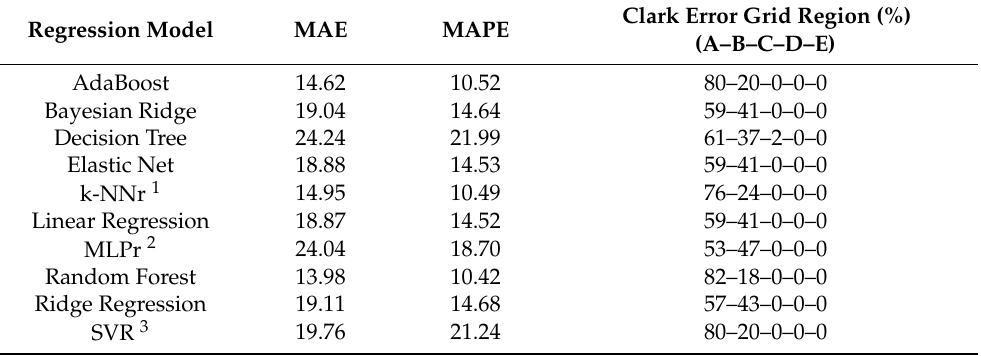
Table 4. Results on the test subset using the first three components of PCA feature extraction.